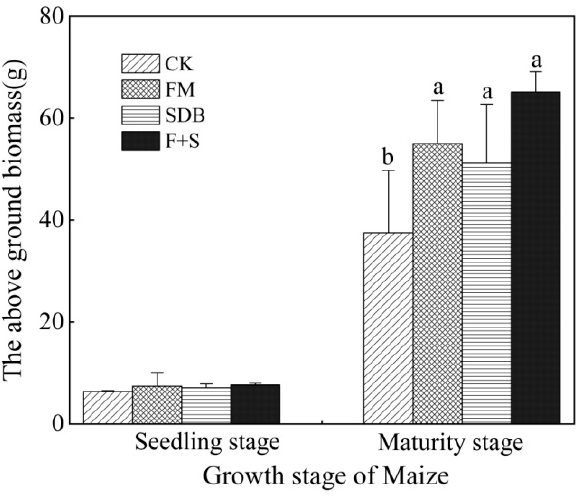
Figure 3. The above-ground biomass of maize at seedling stage and maturity stages. Notes: The “a” and “b” indicates that there is a significant difference between the